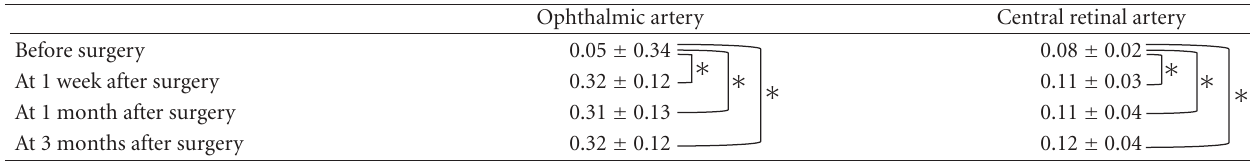
Table 1: Course of peak systolic flow velocity (m/sec).